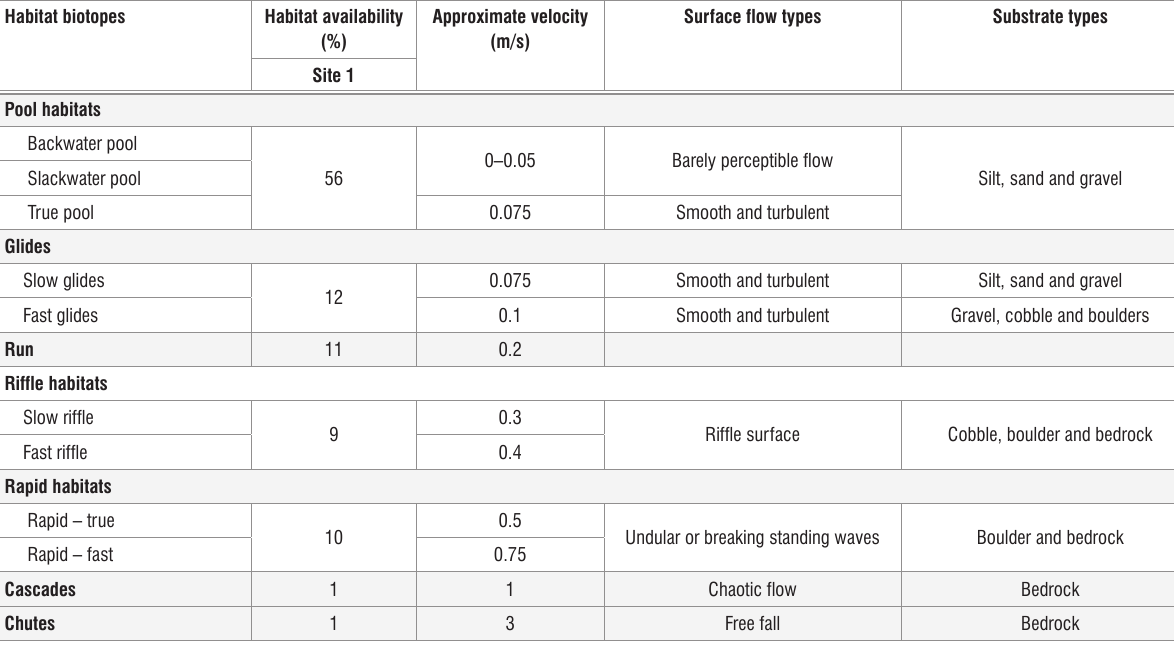
Table 1: Habitat biotope types recorded in the study for yellowfish in the Vaal River Habitat biotopes Habitat availability